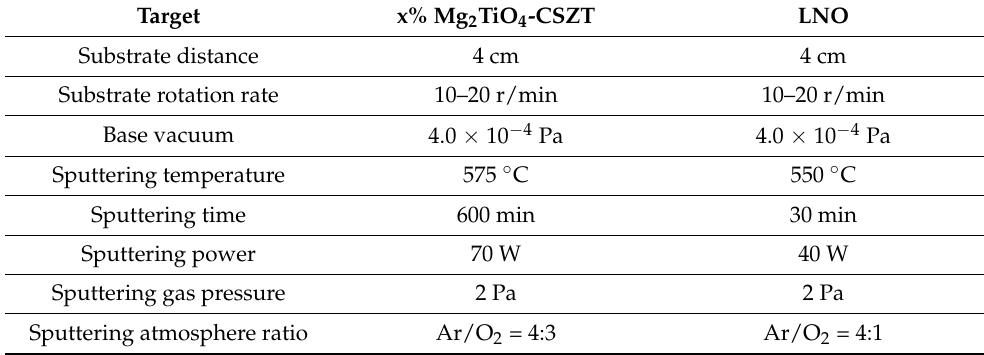
Table 1. The sputtering process parameters of x% Mg 2 TiO 4 -CSZT thin films and LNO buffer